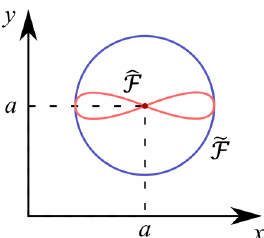
Figure 1. Illustration of Theorem 1. The red line corresponds to the double-loop trajectory ℱ (cid:3549) obtained by the differential approach, the blue line corresponds to cyclic trajectory ℱ (cid:3557) obtained by the integration approach. Here, 𝑥 and 𝑦 are phase variables.